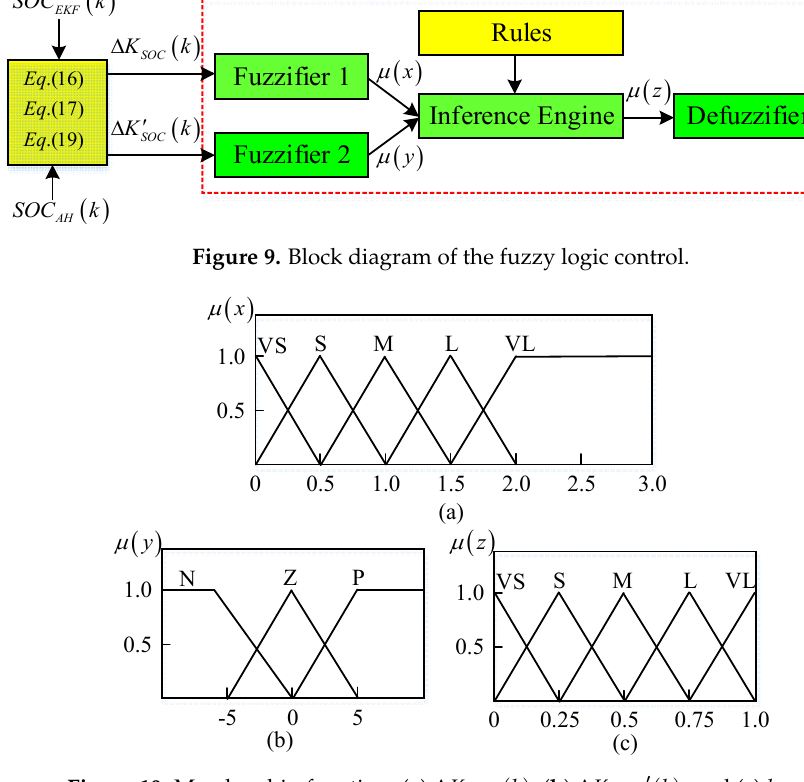
Figure 10. Membership function. ( a ) ∆ K SOC ( k ) ; ( b ) ∆ K SOC (cid:48) ( k ) ; and ( c ) k FLC